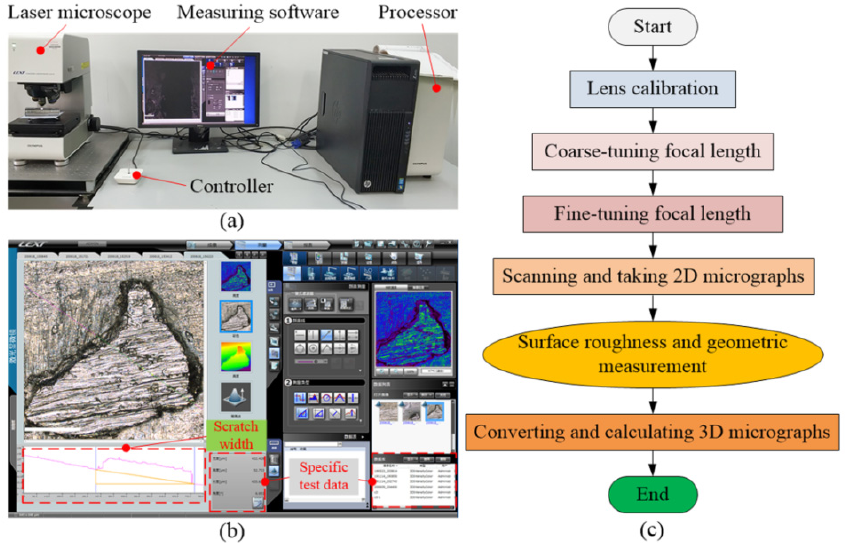
Figure 5. OLYMPUS OLS4100 3D measuring laser microscope: ( a ) system composition, ( b ) meas- urement interface and ( c ) measurement procedure.